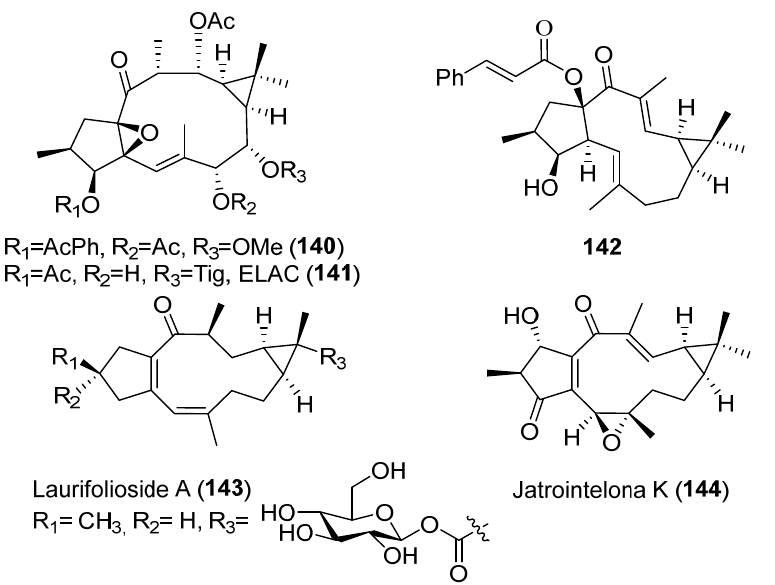
Figure 25. Structure of lathyranes with antiviral or HIV-1 reactivation